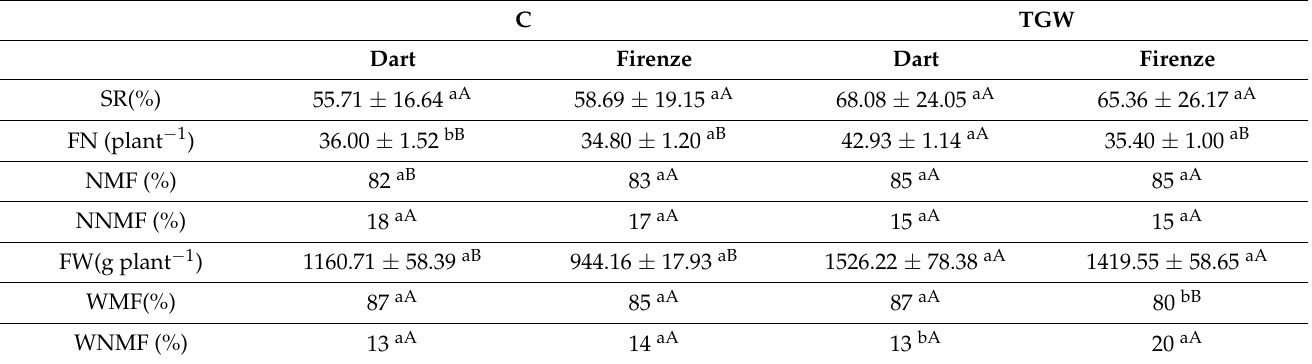
Table 6. Changes in the setting rate (SR), fruit number (FN), number of marketable fruits (NMF%), number of non-marketable fruits (NNMF%), fruit weight (FW), weight of marketable fruits (WMF %), weight of non-marketable fruits (WNMF%) of two tomato cultivars irrigated with ground water (C) and treated grey water (TGW).